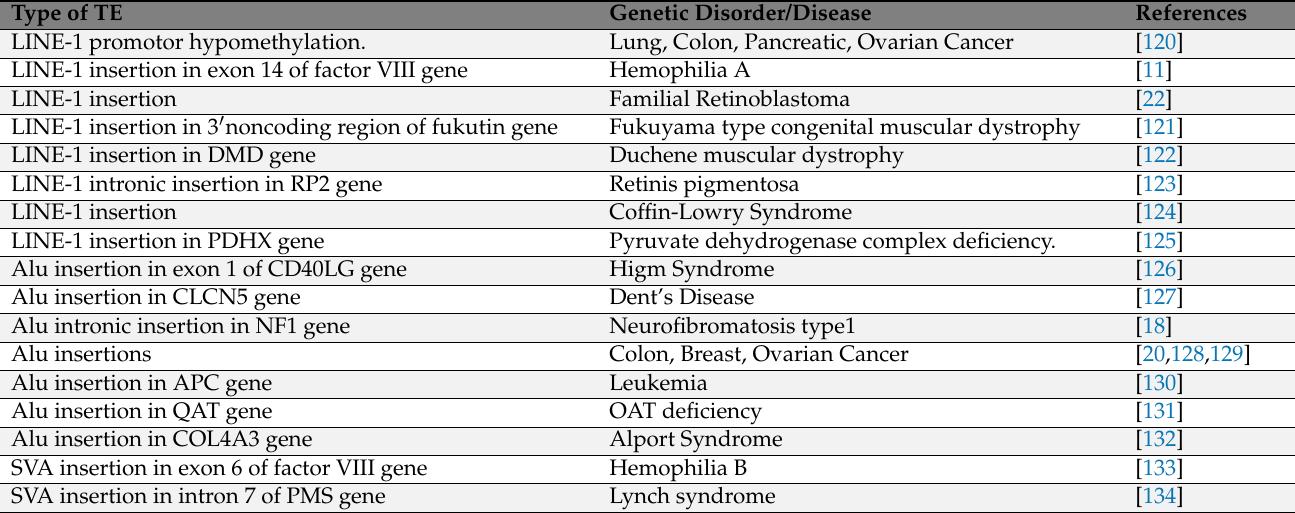
Table 1. Transposable elements and their associated human